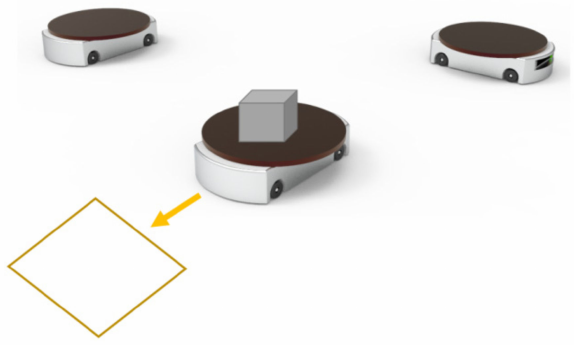
Figure 1. AGV for logistics